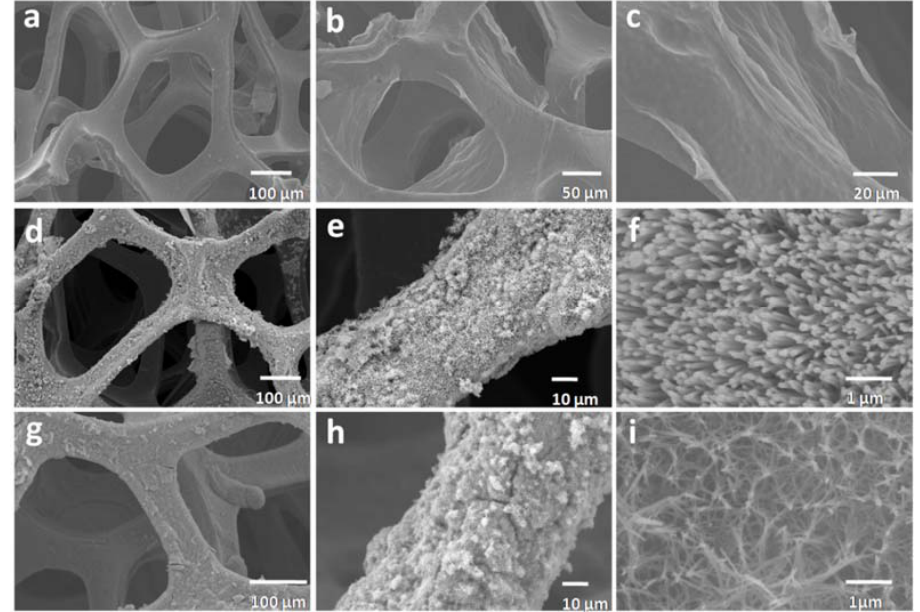
Figure 1. SEM images of Ni foam ( a ), reduced graphene oxide (RGO)@NF ( b , c ), ZnO@NF ( d – f ), and ZnO/RGO@NF ( g – i